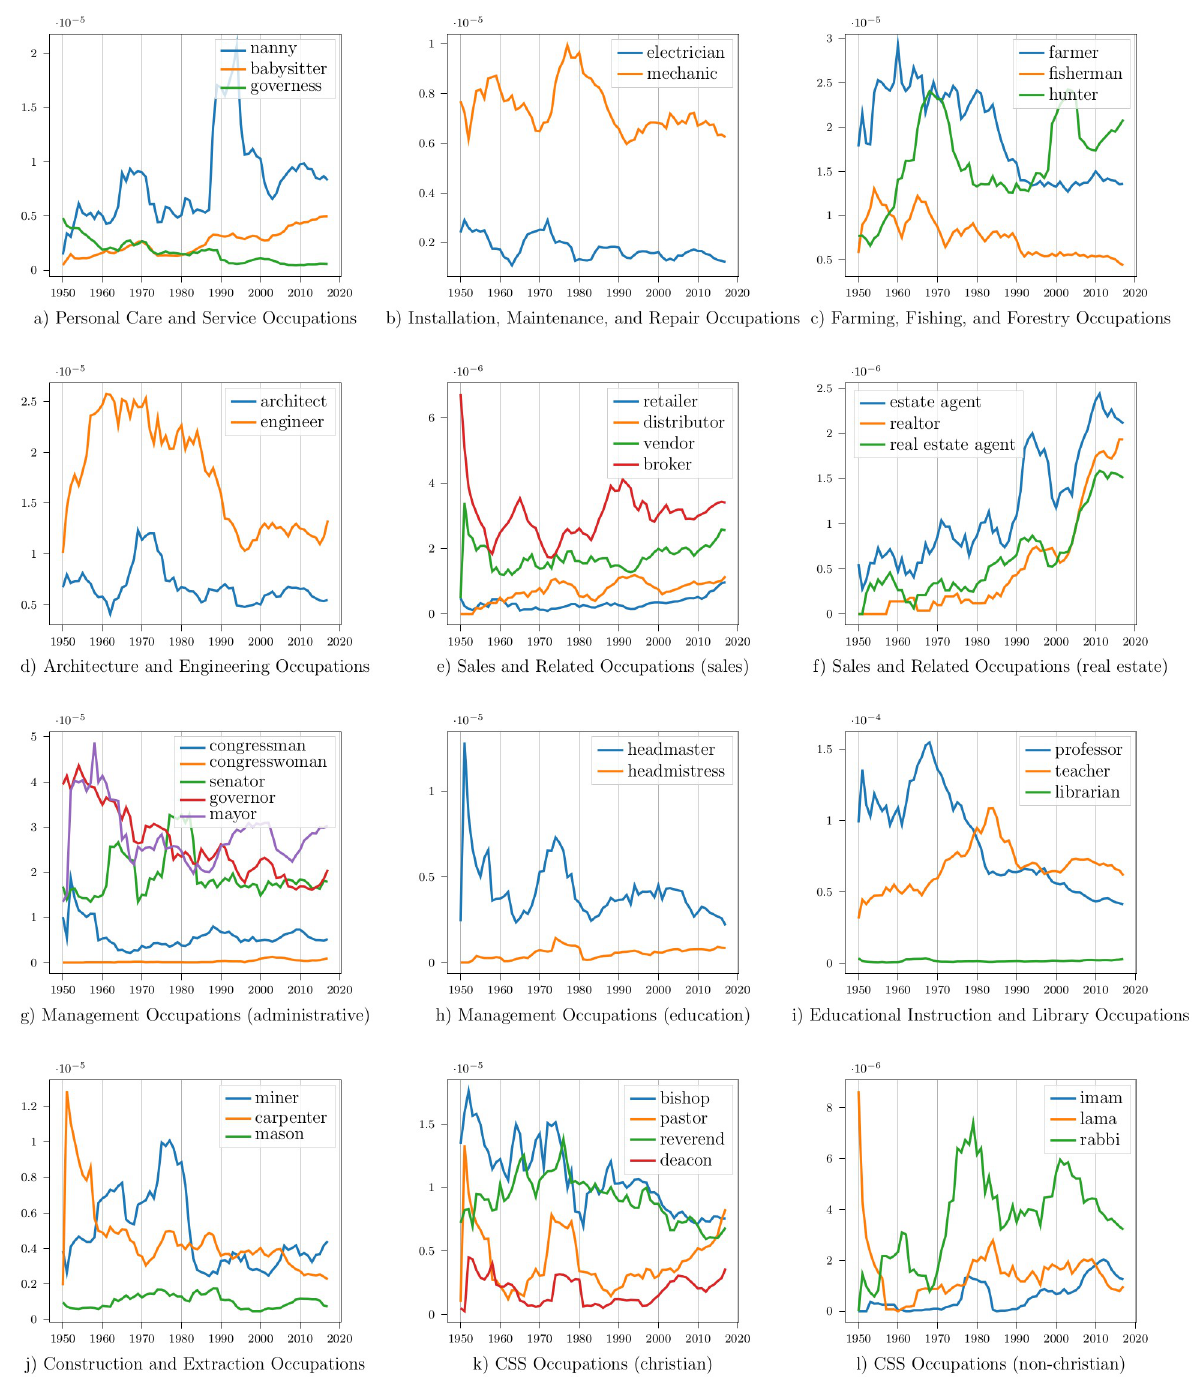
Fig 8. Frequency trends of different professions over time in media subtitles. CSS = Community and Social Service.